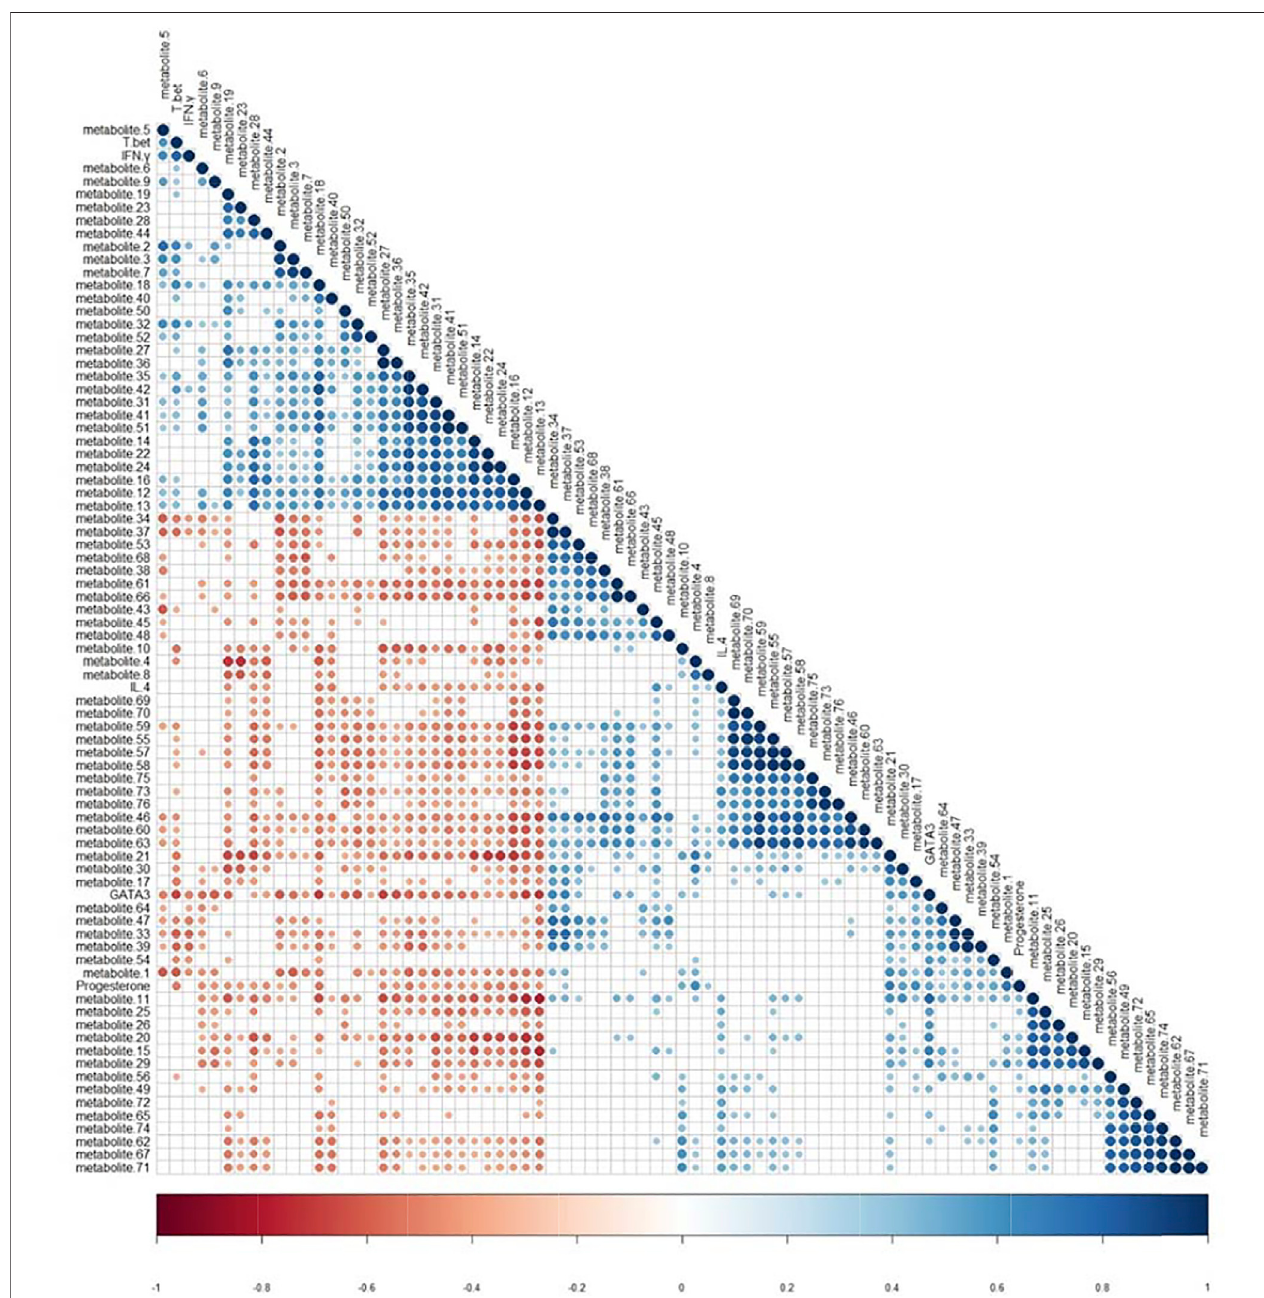
FIGURE 7 | Pearson correlation coef fi cient analysis of biochemical indicators (progesterone, T-bet, GATA-3, IFN- γ , IL-4) and potential biomarkers (Blue: positive correlation, Red: negative correlation).